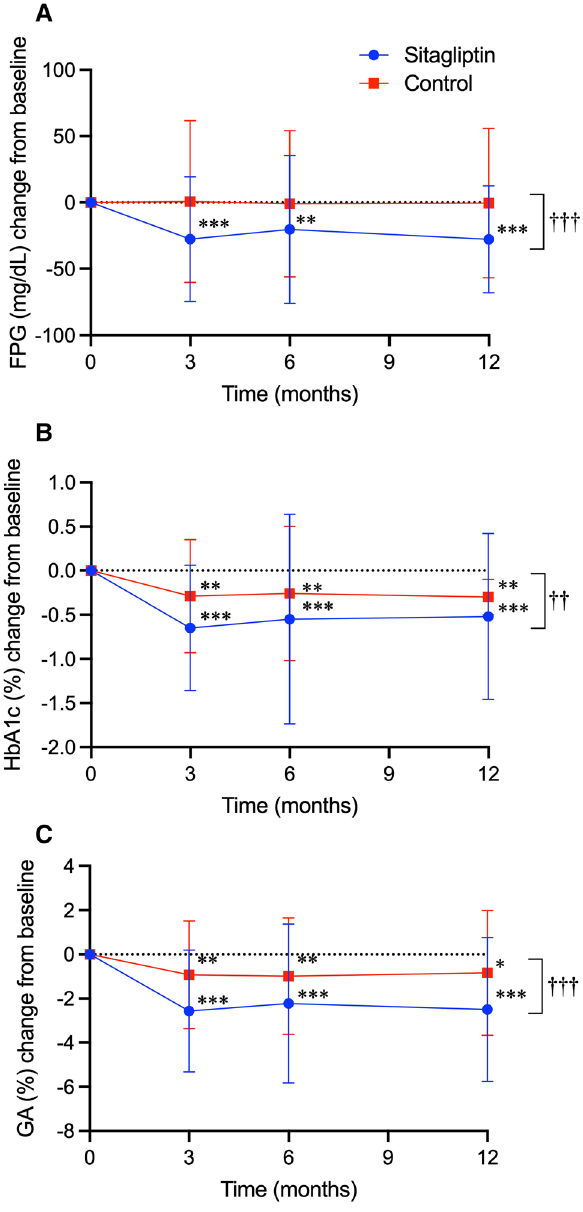
Figure 2. Treatment effect of sitagliptin on glycemic parameters. Changes in fasting plasma glucose (FPG, mg/ dL) ( A ), glycated hemoglobin (HbA1c, %) ( B ) and glycated albumin (GA, %) ( C ) from baseline in sitagliptin and control groups are shown in closed circles with blue lines and closed squares with red lines, respectively. Data are expressed as mean ± standard deviation of the mean. * P < 0.05; ** P < 0.01; *** P < 0.001 vs . baseline in each group on paired t -test. † P < 0.05; †† P < 0.01; ††† P < 0.001 vs. control group on the mixed-effects model